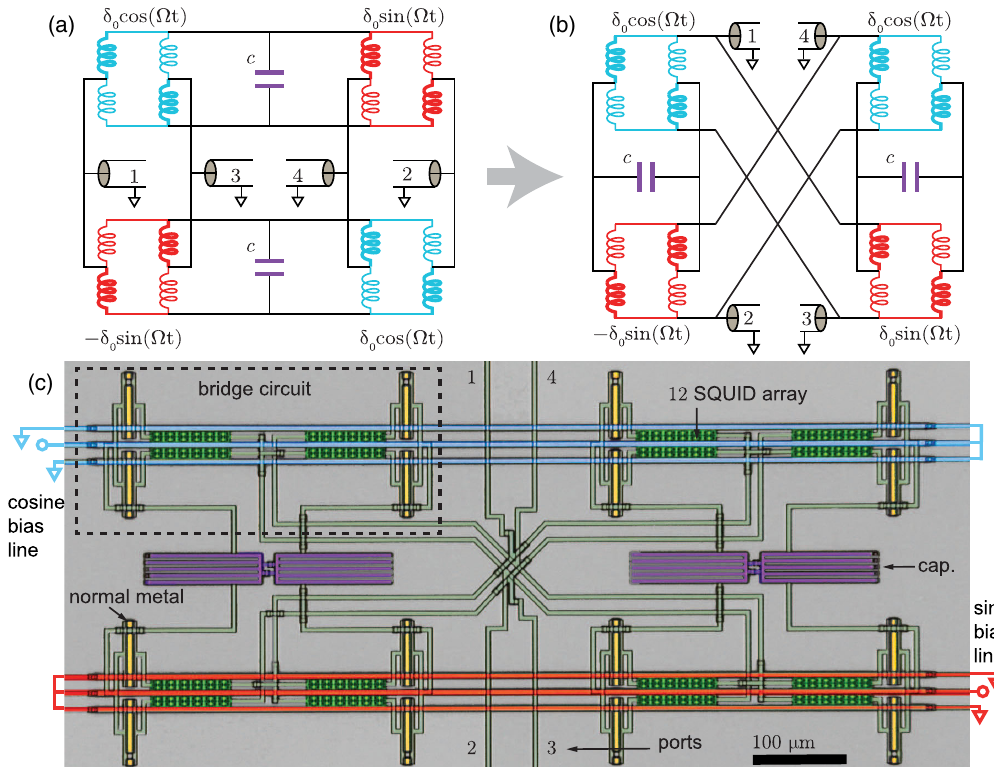
FIG. 4. Superconducting realization of a four-port circulator. (a) Lumped-element schematic of the circulator, constructed with four inductive bridge circuits and two capacitors. Bias lines (not shown) tune the imbalance δ of the four bridge circuits dynamically. (b) The schematic in (a) redrawn to better match the device layout. The rearrangement allows biasing of the bridge circuits with a pair of straight flux-control lines. (c) False-color optical micrograph of the circulator chip. A dashed black box indicates one of the four bridge circuits, created with four 12-SQUID arrays (green) arranged in the figure-eight geometry described in Fig. 3(c). Parallel-plate capacitors (purple) provide the capacitance needed for the resonant delay. Bias lines (red and blue) traverse the chip and imbalance the bridge circuits with a gradiometric